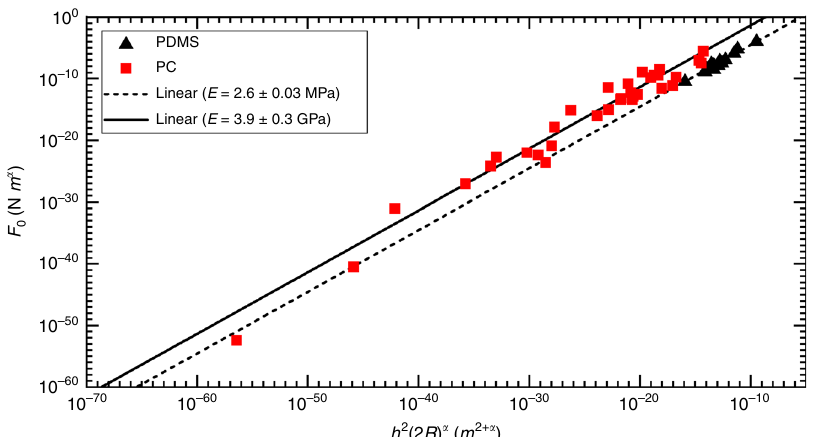
Fig. 4 Force amplitude plotted against h 2 (2 R ) α . All data are well fi t by Eq. 1, yielding a measured value for Young ’ s modulus for each polymer that agrees with traditional mechanical measurements